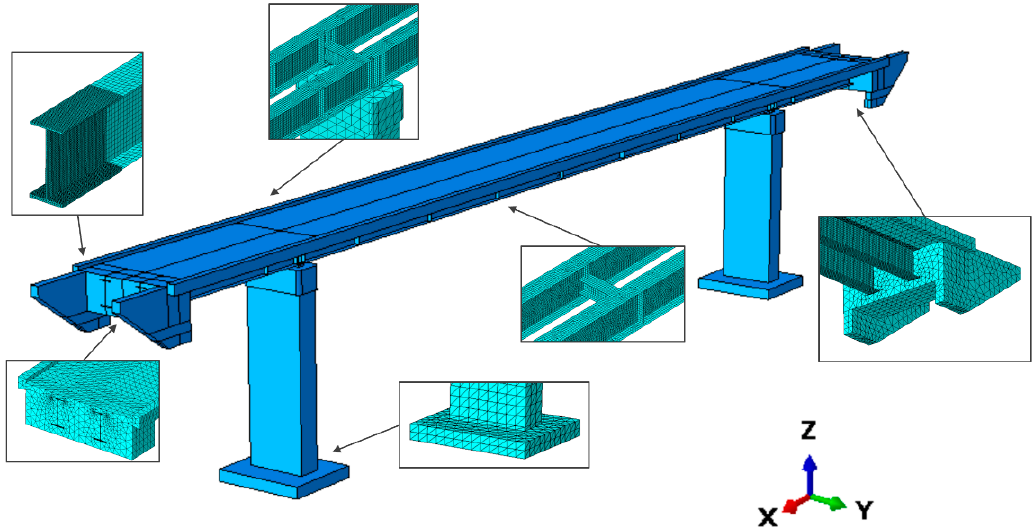
Figure 11. The numerical model of the footbridge with elements and mesh details.